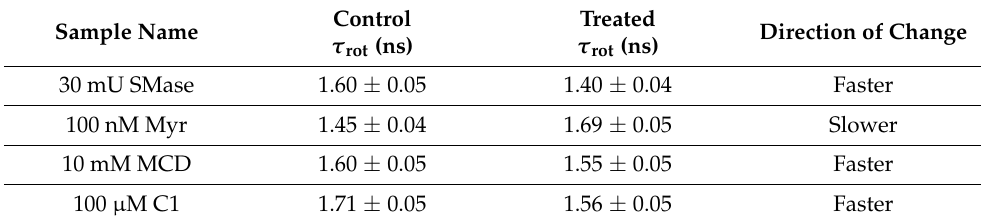
Figure 4. Anisotropy decay of LAURDAN. λ = 450 nm. Black—Anisotropy data. Red—1-exponential fit. A higher τ rot value means the slower rotational motion of LAURDAN, while a lower τ rot value means the faster rotational motion of LAURDAN. The calculated rotational lifetime values based on treated and untreated samples are given in Table 3. Table 3. τ rot values in control and treated samples. Errors are the intrinsic measurement errors.